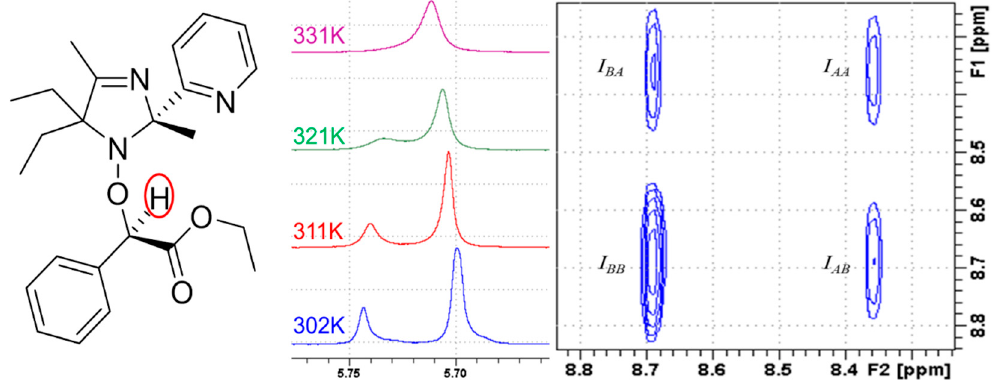
Figure 2. Center— 1 H DNMR spectra of 2 RS/SR at different temperatures. Right—fragment of the 2D NOESY/EXSY spectrum of 2 RS/SR at 290 K showing the signals from the proton highlighted on the Left. Figure 1. 1 H NMR spectra in the region of the proton at the tertiary chiral carbon center for the two diastereomers 2 RS/SR and 2 RR/SS . For each diastereomer, the highlighted regions correspond to the respective invertomers.